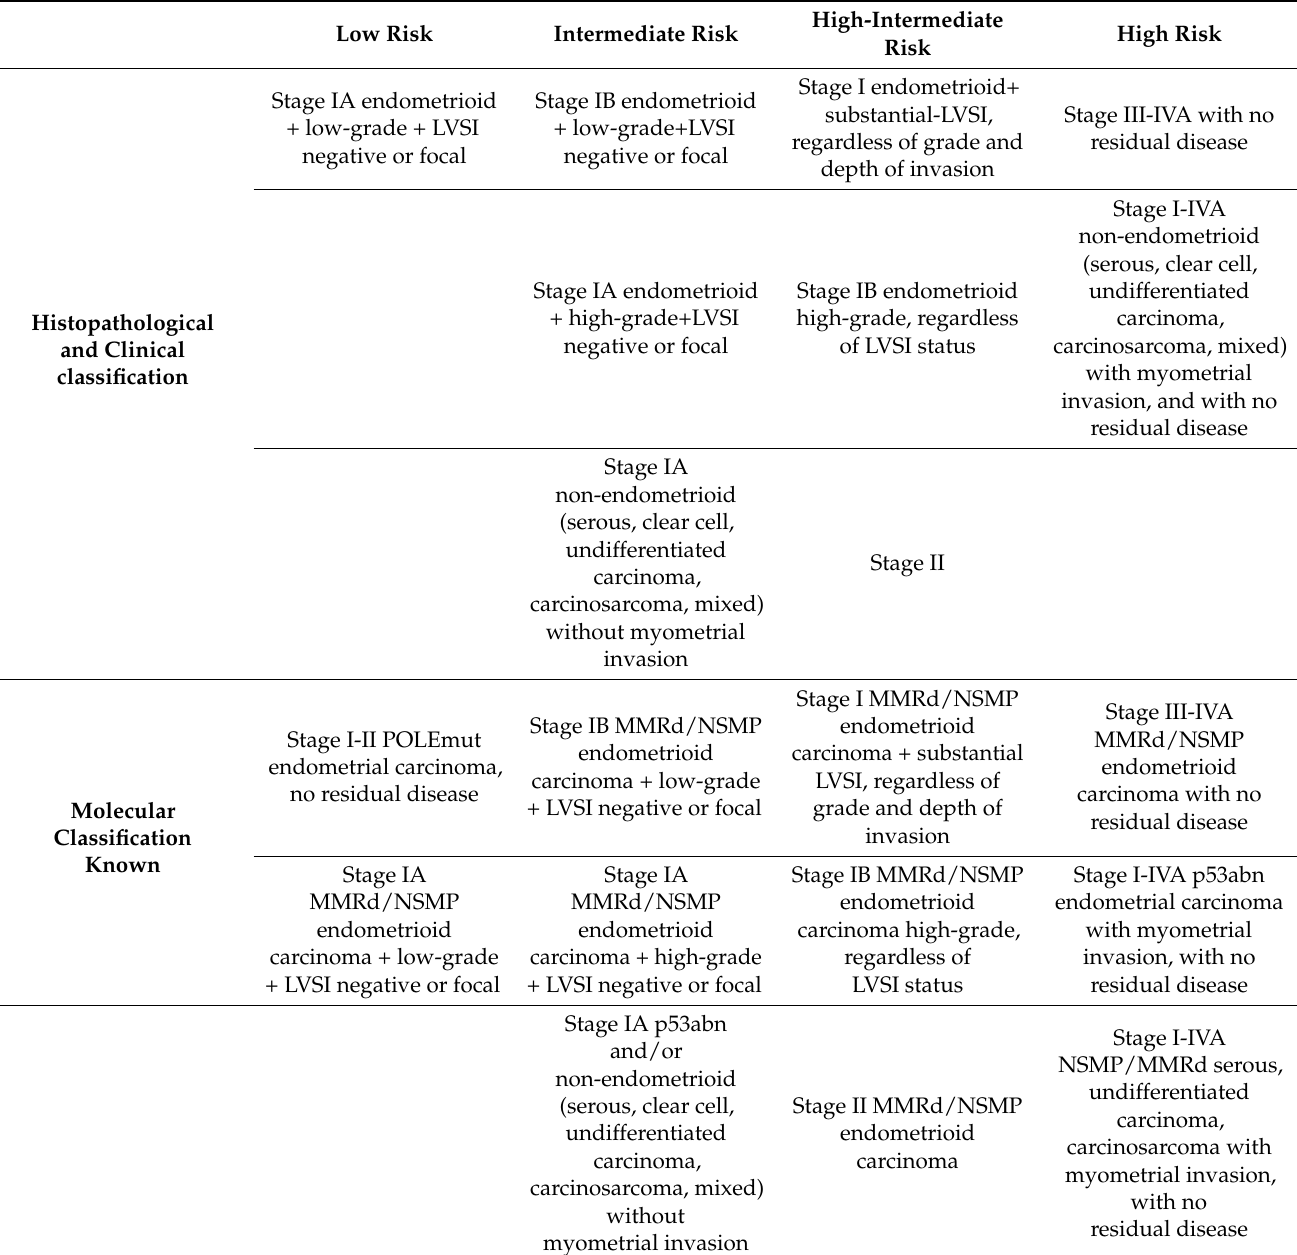
Table 1. Endometrial cancer